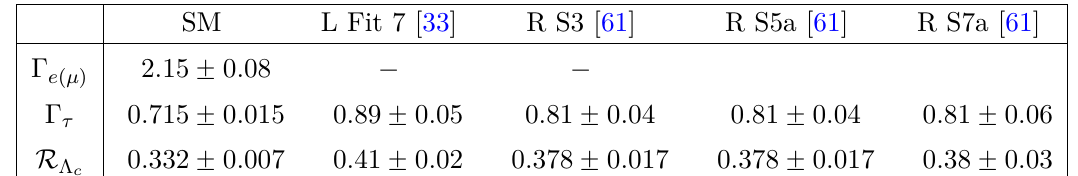
(cid:0) Γ Λ Λ (cid:0) (cid:8) b (cid:209) c e p µ q e p µ q (cid:16) Γ Γ p Λ Λ ¯ ν Λ Λ ¯ ν obtained in the b (cid:209) c τ τ q { b (cid:209) c e p µ q e p µ q